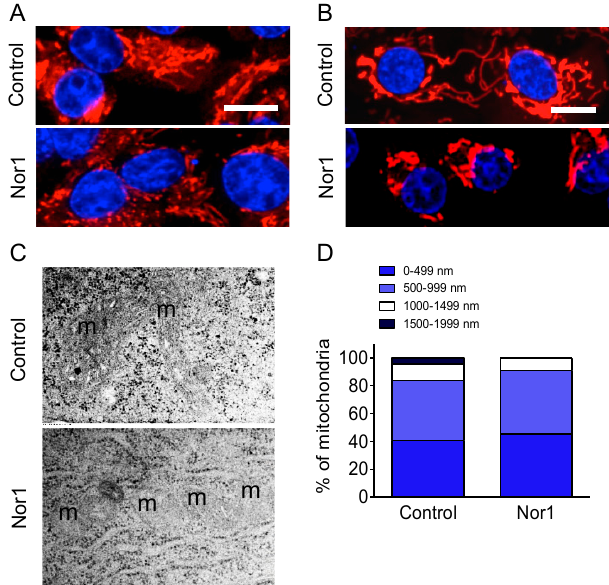
Figure 4. Nor1 induces mitochondrial fractionation in beta cells. Representative images of INS832/13 cells ( A ) or dispersed human islet cells ( B ) transfected with Nor1-Flag (bottom) or a control flag vector (top). Mitochondria were stained using Mitotracker Red, and the nuclei using Hoechst. Scale bars = 10 µm. ( C ) TEM images showing mitochondrial fractionation in INS cells transfected with Nor1 (bottom) compared to a control vector (top). m denotes mitochondria. ( D ) Quantification of the number of mitochondria by size groups in TEM images.